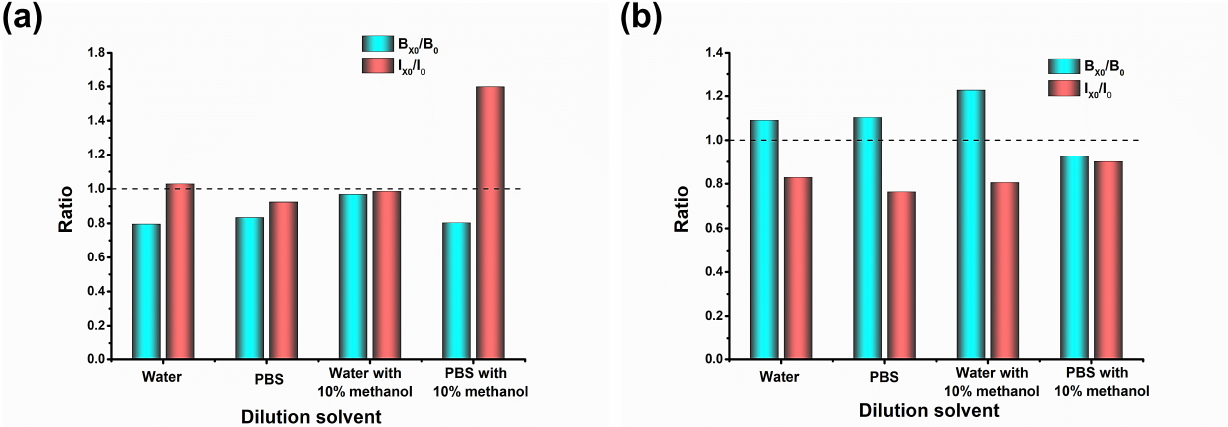
Figure 2. The screening of dilution solvent. ( a ) MRL 60 μ g/kg; ( b ) MRL 500 μ g/kg. The I 0 and I X0 were the inhibition values of solvent and matrix at 0.5 ng/mL, respectively; the B 0 and B X0 were the values of blank solvent and blank matrix, respectively.